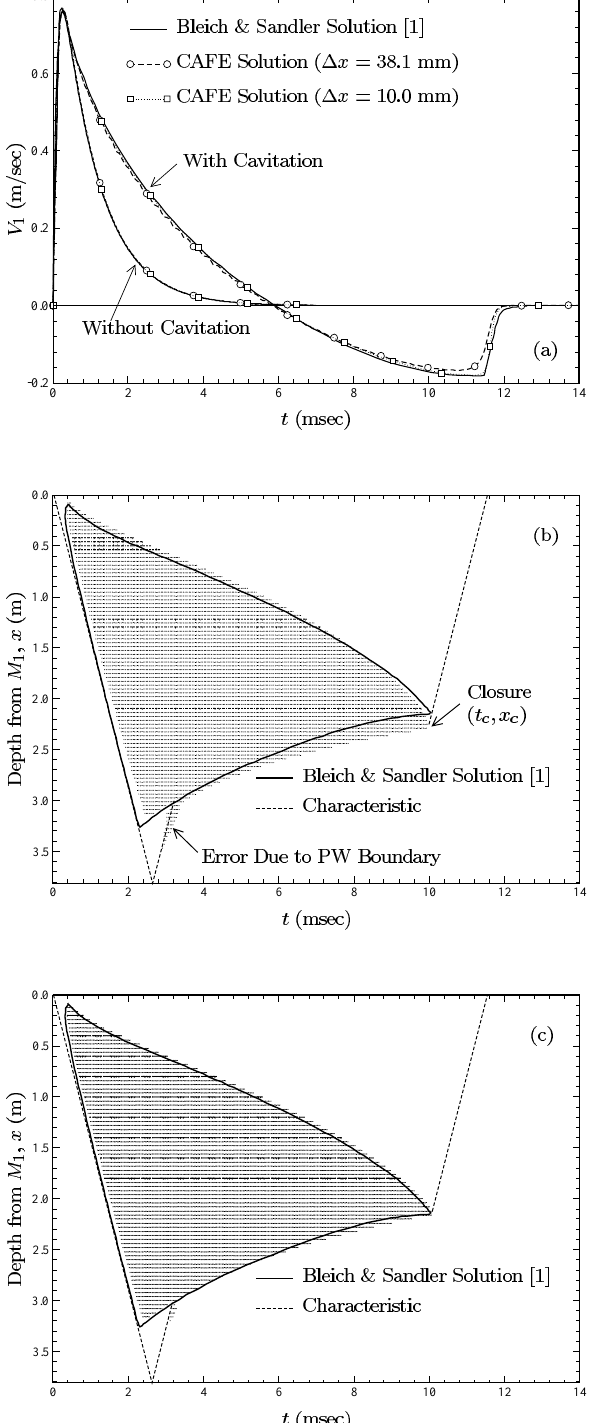
Fig. 2. Validation of the CAFE method with the Bleich and Sandler problem [ ? ]. (a) V 1 -response histories for M 2 /M 1 = 0 . (b) Cavitation zone; horizontal lines indicate cavitated zone of CAFE